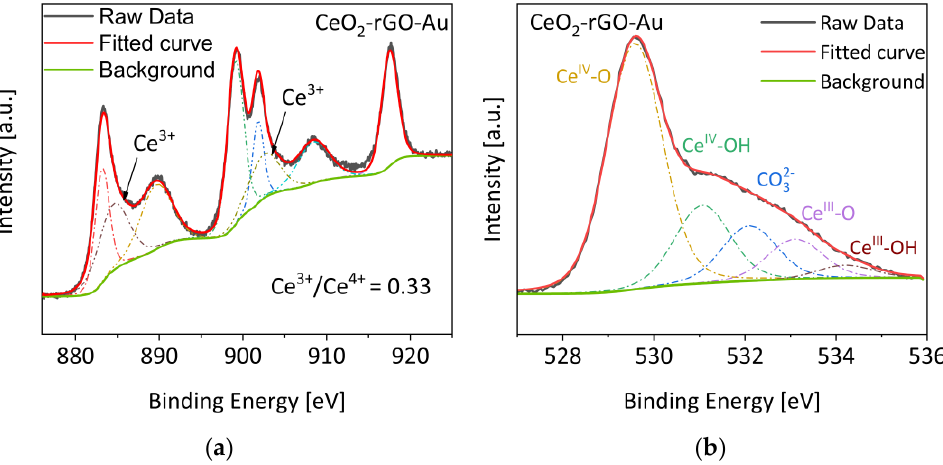
Figure 7. ( a ) Ce 3d and ( b ) O 1s XPS spectra of CeO 2 -rGO-Au. The deconvolution curves of the single components are depicted by dashed/dotted lines. components are depicted by dashed/dotted